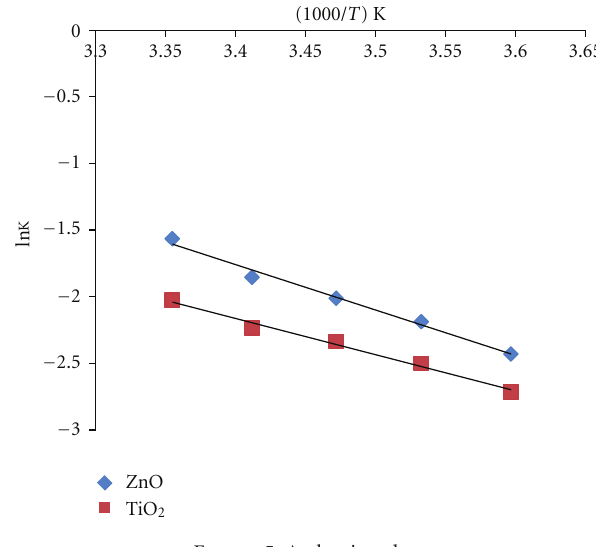
Figure 5: Arrhenius